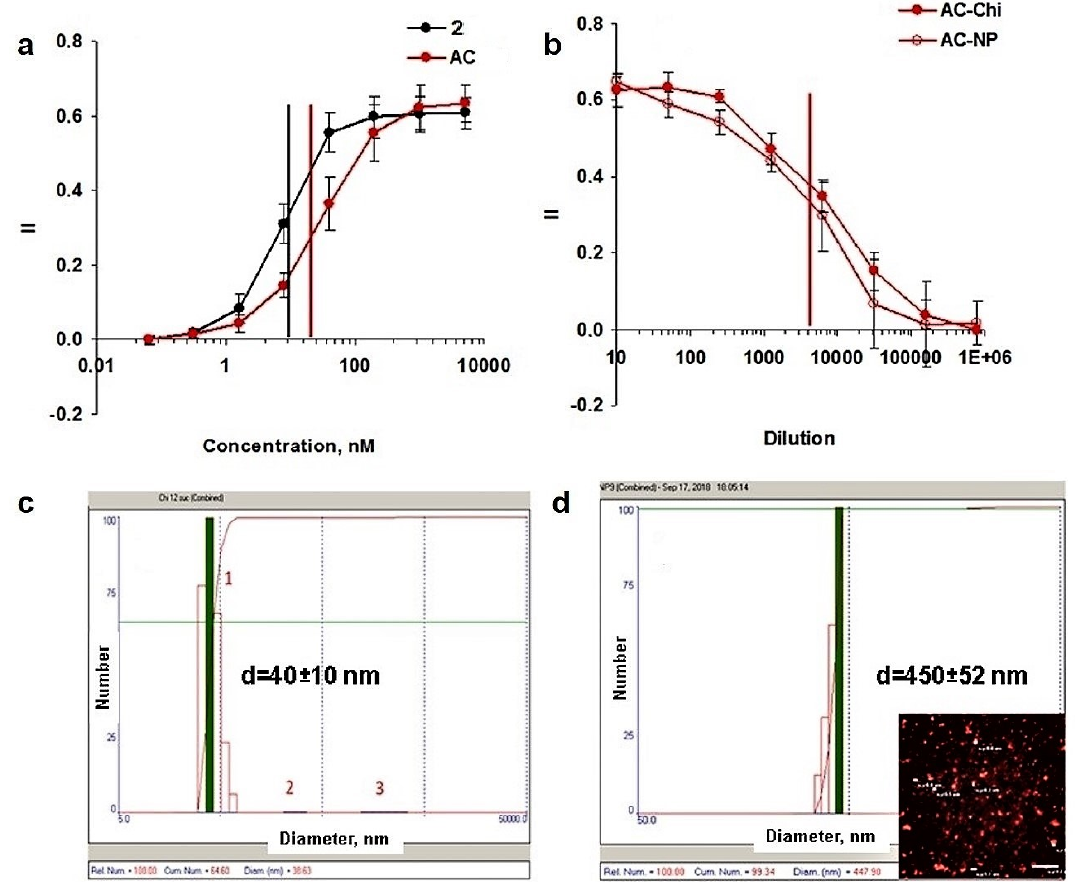
Figure 2. Cytotoxic activity of furano-allocolchicinoid 2 in different formulations. ( a , b ) Inhibition of cell proliferation by unlabeled ( 2 , black) or rhodamine B labeled furano-allocolchicinoid ( AC , red) ( a ); AC-Chi and AC-NPs ( b ) estimated by 72 h MTT assay in PANC-1 cells. IC 50 is shown with vertical lines of corresponding colors. ( c , d ) Average diameter of AC-Chi ( c ) and AC-NPs ( d ) estimated by dynamic light scattering. Insertion shows AC-NPs confocal image. Bars show diameters of some nanoparticles.